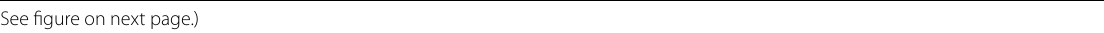
mother, n 23 pairs; HU vs + = women filled +